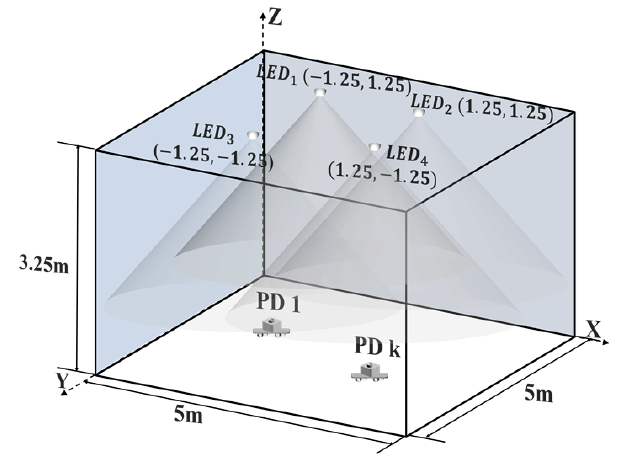
Figure 2. Diagram of the simulation model for the multi-user VLCP system.